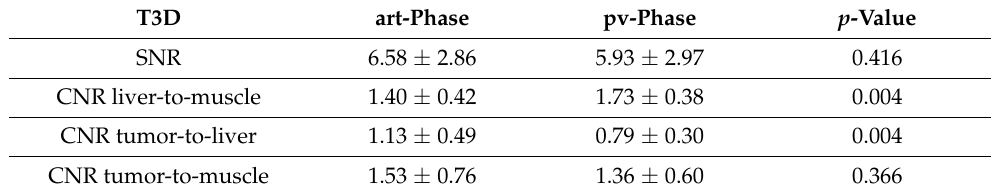
Table 3. SNR and CNR of low-energy threshold images (T3D). SNR: signal-to-noise ratio; CNR: contrast-to-noise ratio; art-phase: arterial upper abdomen phase; pv-phase: portal venous abdomi- nal